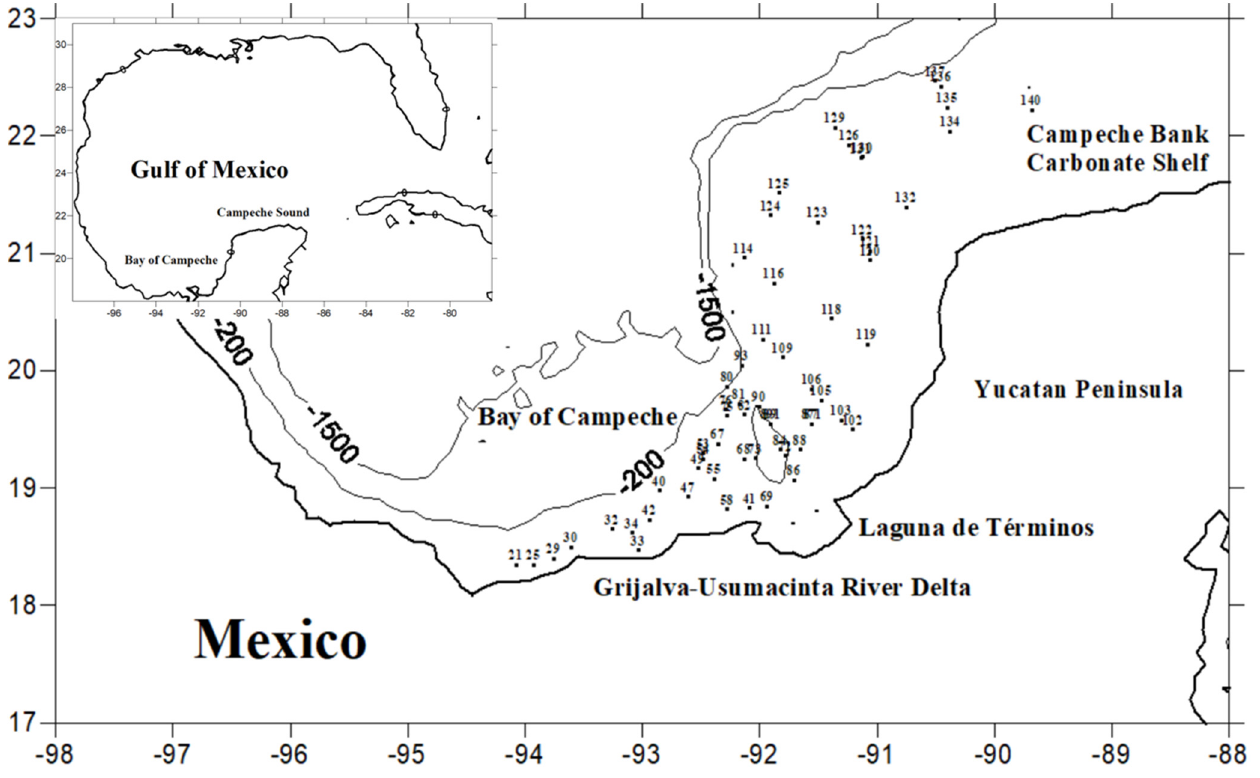
Figure 1. Sampling stations in the Southern Gulf of